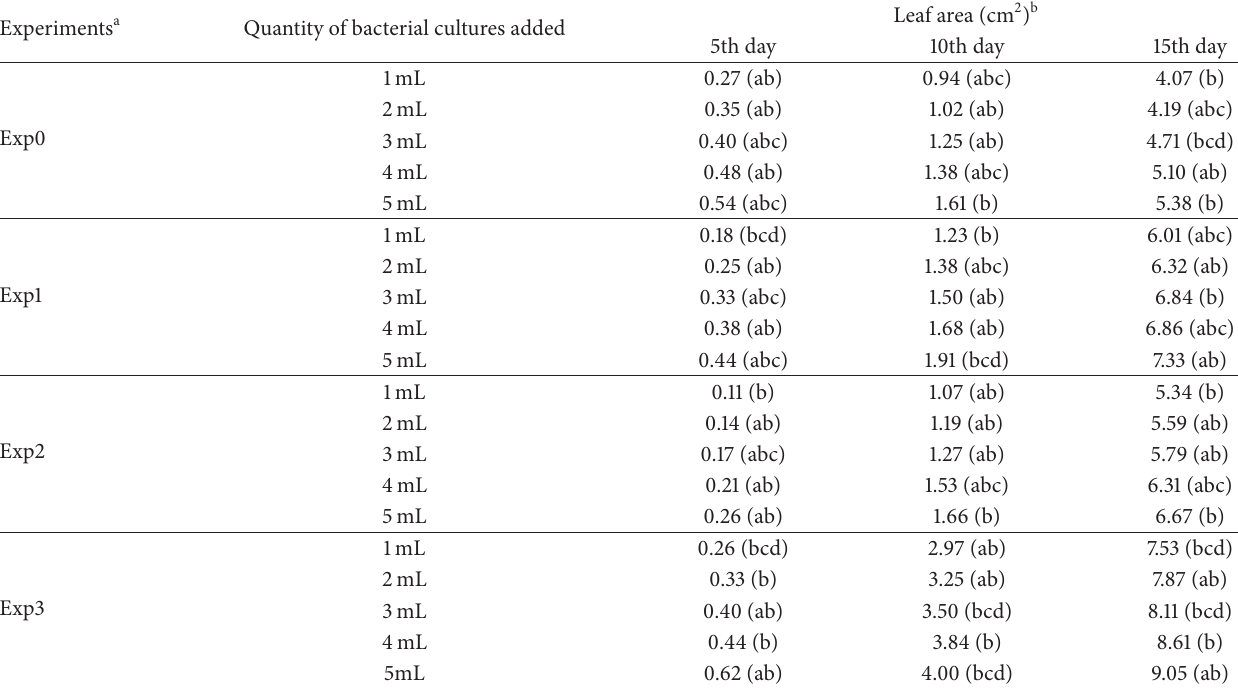
Table 4: Leaf area of Vigna unguiculata grown on vermiculite supplemented with Bacillus cereus , with Pseudomonas spp., and with their consortium (1:1) at five different concentrations (1, 2, 3, 4, and 5mL) on the 5th, the 10th, and the 15th days and in the control.